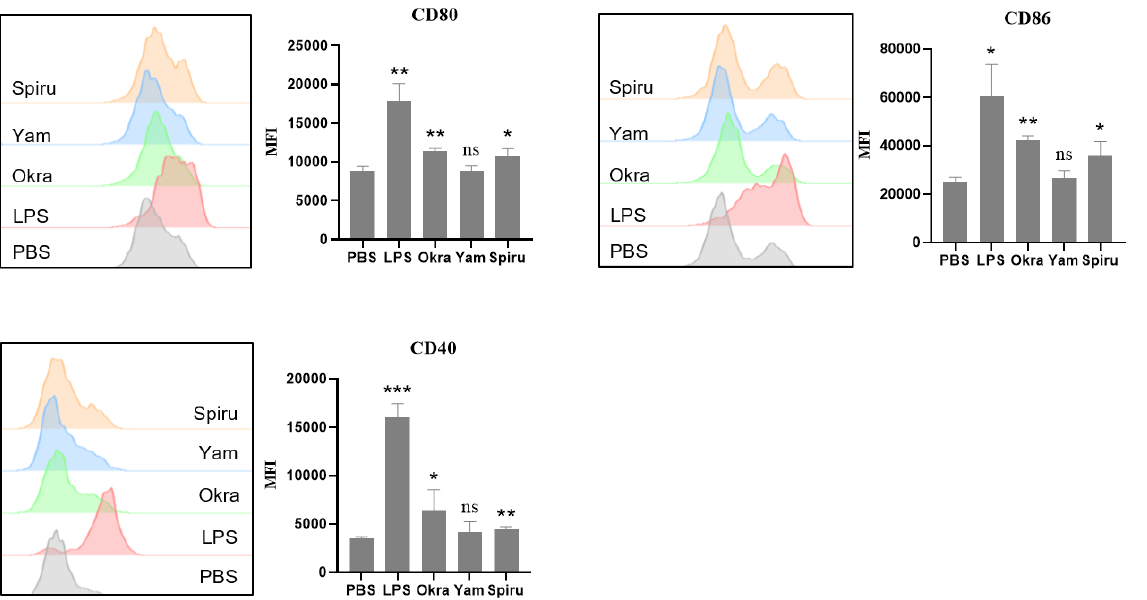
Figure 7. Effects of polysaccharides on BMDC maturation. Induced BMDCs were cultured, and five groups were set up: negative control of PBS, positive control of 1 μg/mL LPS, and 50 μg/mL of okra polysaccharide, yam polysaccharide, and spirulina polysaccharide. After 24 h of incubation, cells were collected, stained with anti-CD11c-APC, anti-CD80-PerCP-efluor TM 710, and anti-CD86-PE, and assessed via flow cytometry. * p < 0.05; ** p < 0.01; *** p < 0.001; ns, no significance.